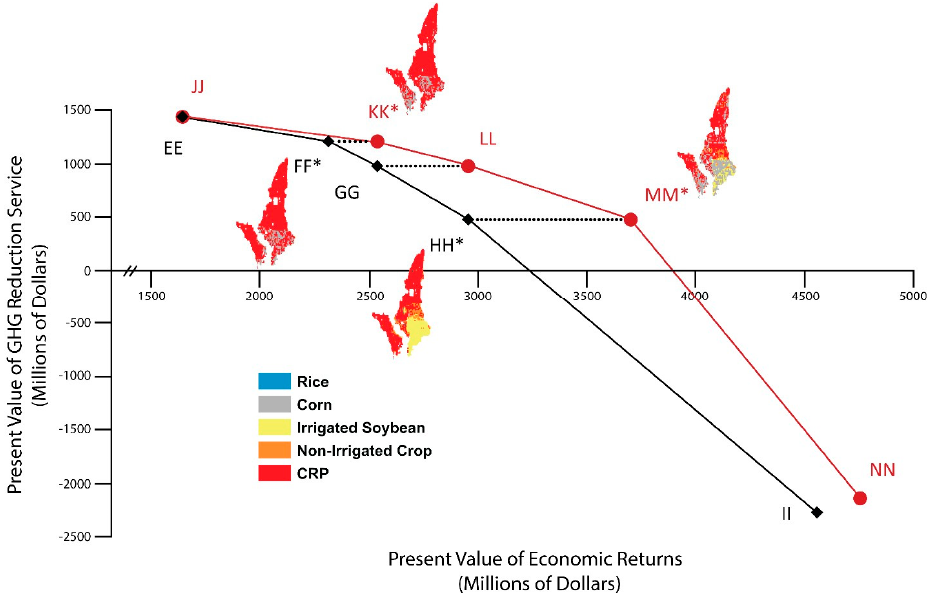
Figure 6. Crop mix patterns associated with specific points along the efficiency frontiers without reservoirs